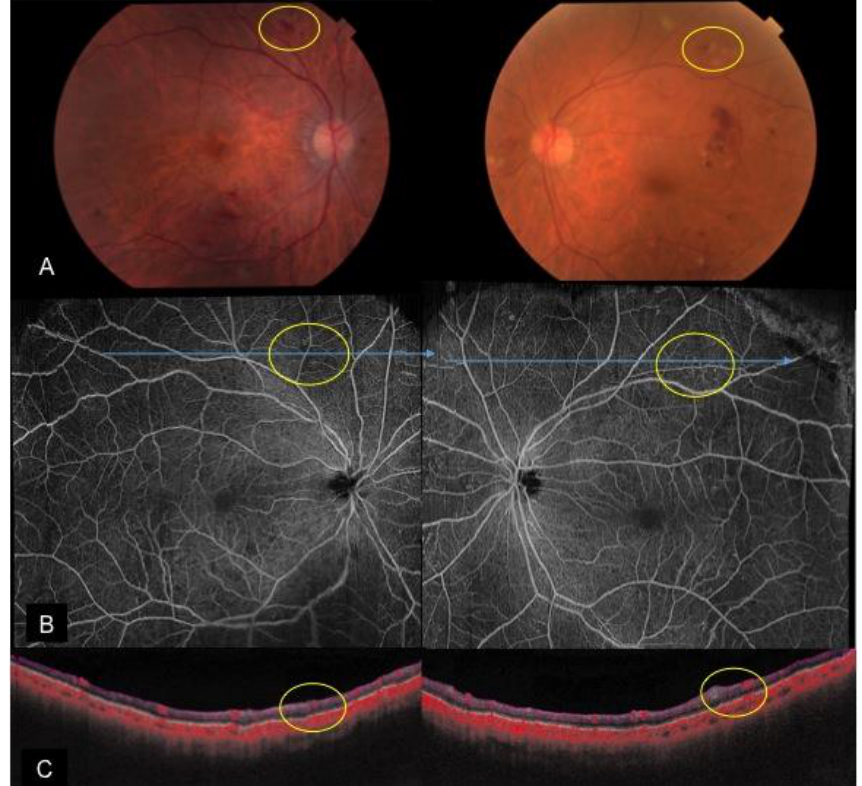
Figure 3. A case of bilateral severe non-proliferative diabetic retinopathy with intraretinal microvascular abnormalities. ( A ): Color fundus photos depicting scattered retinal hemorrhages and cotton wool spots; en face OCTA montage ( B ) and cross-sectional OCTA ( C ) reveal intraretinal microvascular abnormalities (yellow circles) in areas with slightly decreased capillary perfusion.